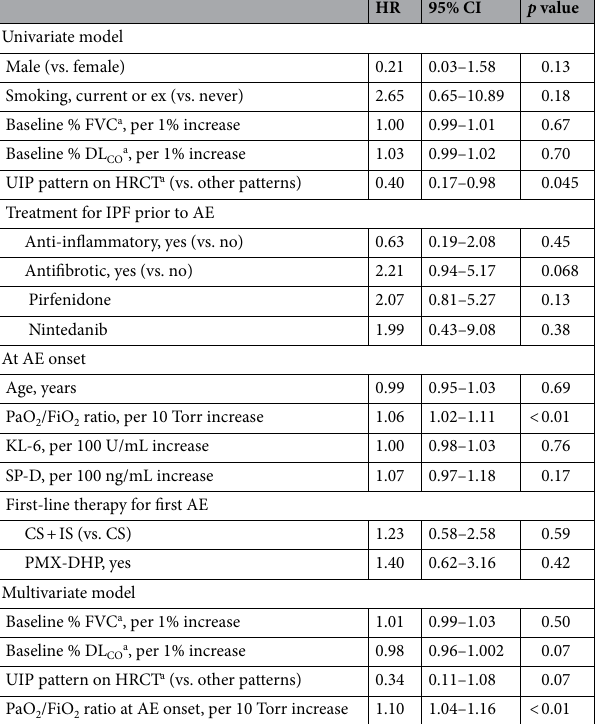
Table 3. Results of fine-gray subdistribution hazards analysis of AE relapse. HR hazards ratio, CI confidence interval, AE acute exacerbation, FVC forced vital capacity, DL CO diffusing capacity of the lung carbon monoxide, UIP usual interstitial pneumonia, HRCT high-resolution computed tomography, CS corticosteroids, IS immunosuppressant, PMX-DHP polymyxin-B direct hemoperfusion, KL-6 Krebs von den Lungen-6, SP-D surfactant protein D. a Within 12 months before first